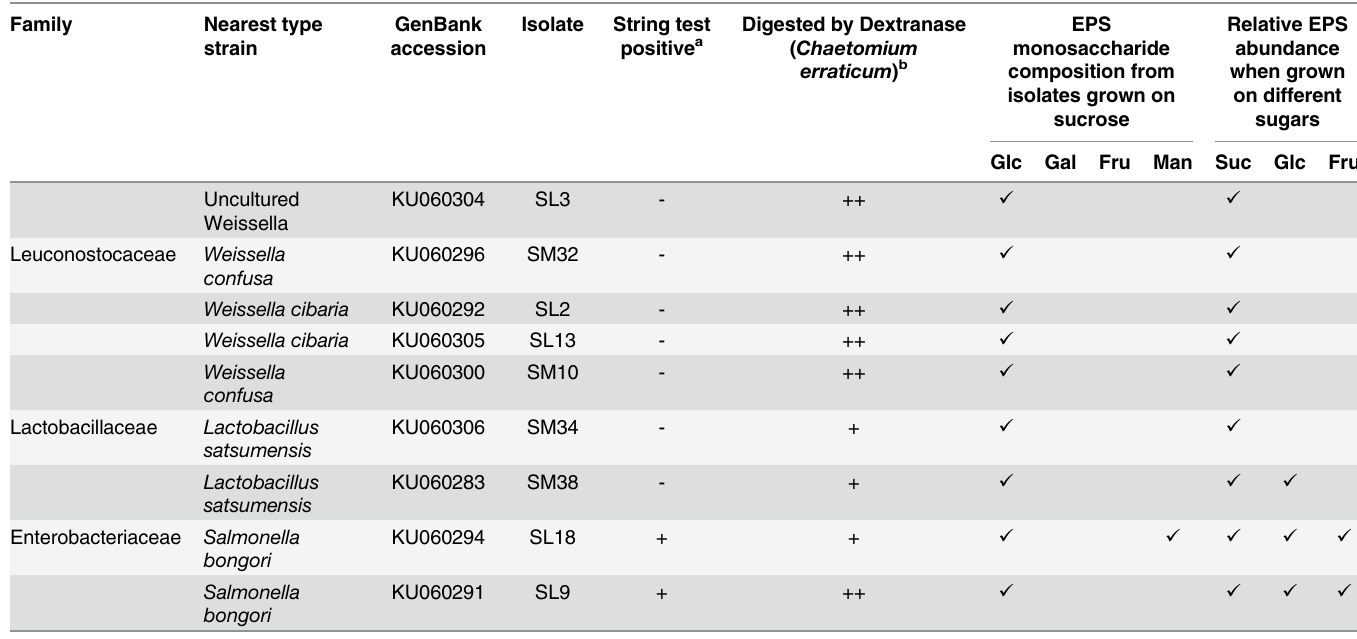
16S rRNA gene sequence